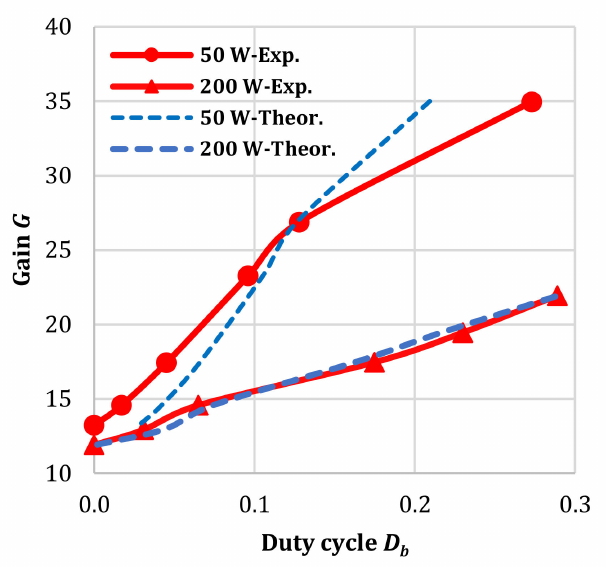
Figure 12. Theoretical and experimental dc voltage gain curves versus the boosting duty cycle D b .